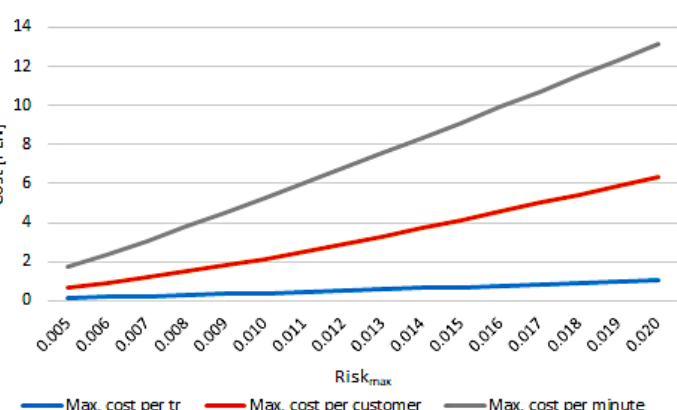
Figure 9. Maximal losses.